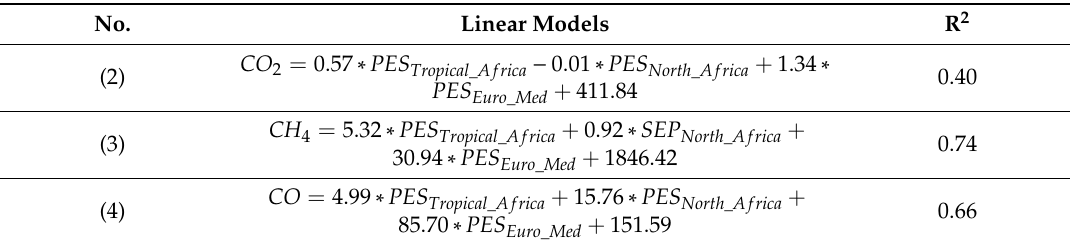
Table A1. Linear Models showing relationships between species (i.e., CO 2 , CH 4 , and CO) and the SEPs over the regions of tropical Africa, North Africa, and the Mediterranean–Europe, and their correlation coe ffi cients (R 2 ) and significance ( p